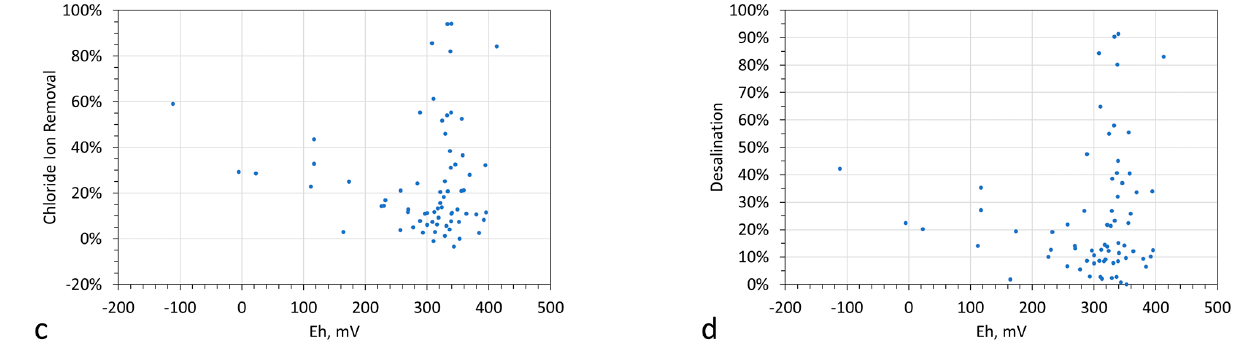
Figure 13. Ion removal: ( a ) chloride vs. sodium; ( b ) sodium vs. Eh; ( c ) chloride vs. Eh; ( d ) NaCl vs. Eh.